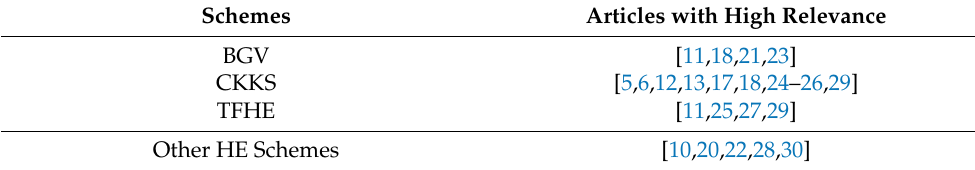
Table 2. Status of homomorphic encryption scheme